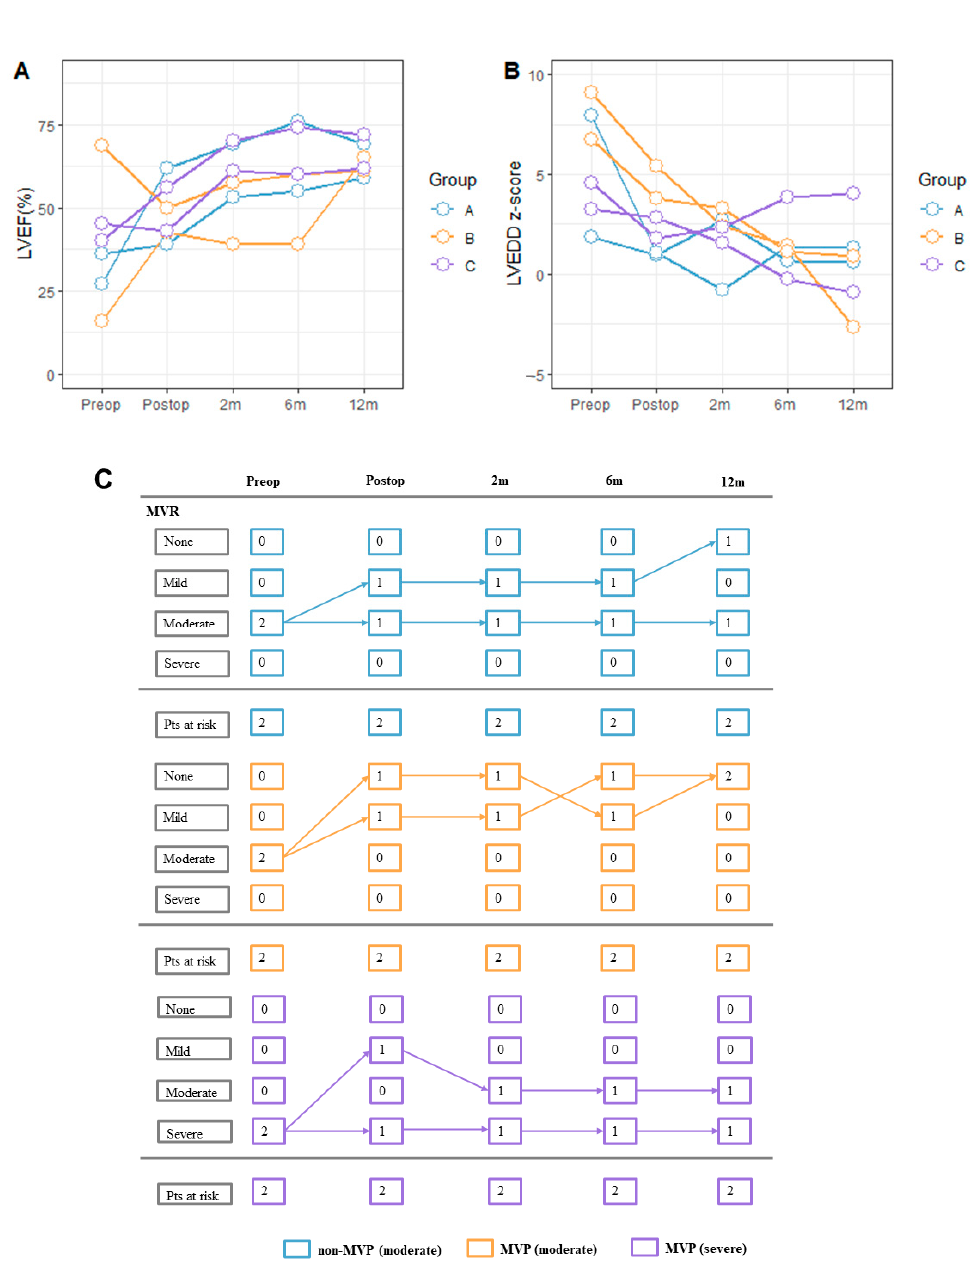
Figure 3. Longitudinal assessment for the primary outcome of each TCAPA patient with and without mitral valve plasty. ( A ) LVEF% of each TCAPA patient at pre-operation, post-operation, and follow- ups. ( B ) LVEED z-score of each TCAPA patient at pre-operation, post-operation, and follow-ups. ( C ) Longitudinal changes in the degree of mitral valve incompetence with the corresponding number of patients at risk. A (blue) indicated non-MVP (moderate) group, B (orange) indicated MVP (mod- erate) group, and C (purple) indicated MVP (severe) group. Abbreviation: LVEED, left ventricular end-diastolic diameter; LVEF, left ventricular ejection fraction; MVR, mitral valve regurgitation; Postop, post-operation; Preop, pre-operation; Pts, patients; TCAPA, total anomalous origin of the coronary arteries from the pulmonary artery.